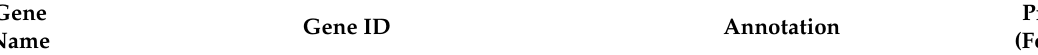
Table 1. Primers for real-time fluorescent quantitative PCR